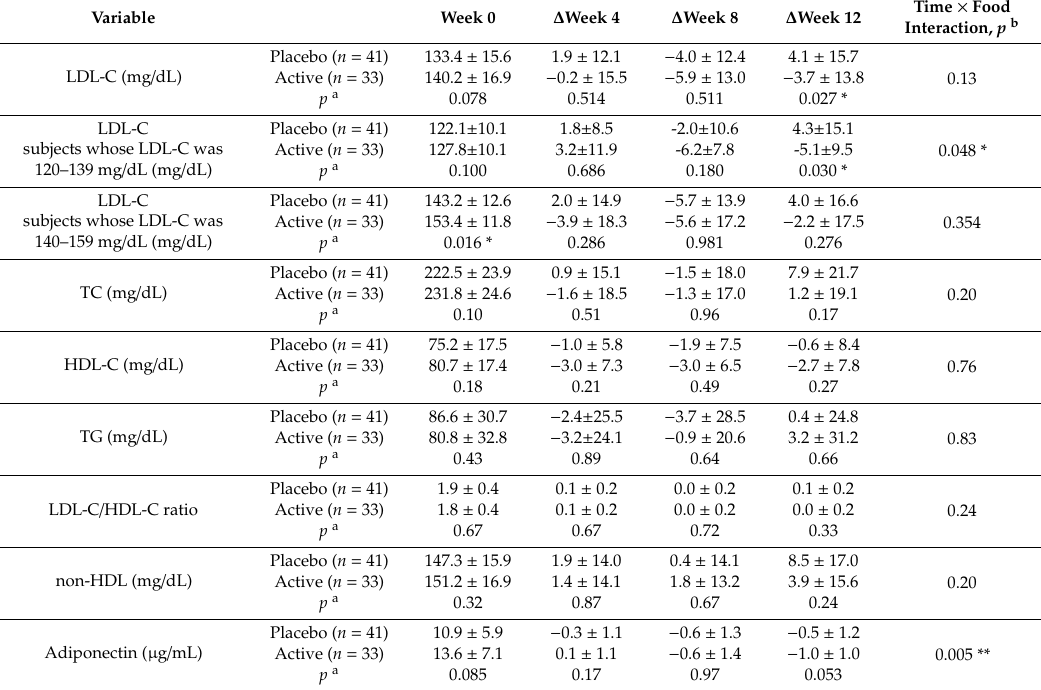
8 of 13 Table 5. Lipid profiles and adiponectin levels for the placebo and active food test groups.